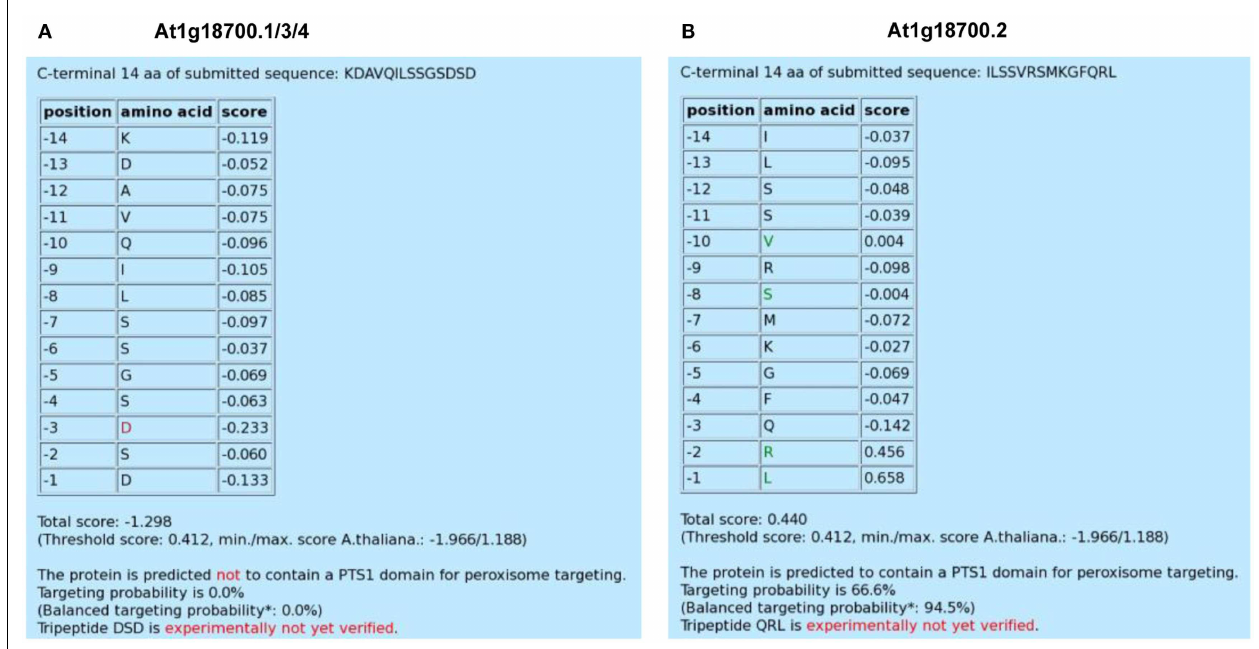
variants differ in size (At1g18700.1, 700 aa; At1g18700.2, 705 aa; At1g18700.3, 695 aa; At1g18700.4, 715 aa). Residues with PWM scores that lie outside a defined interval are highlighted in green and red colors, respectively, and indicate a predicted positive and negative effect on peroxisome targeting by the PTS1 pathway, respectively.